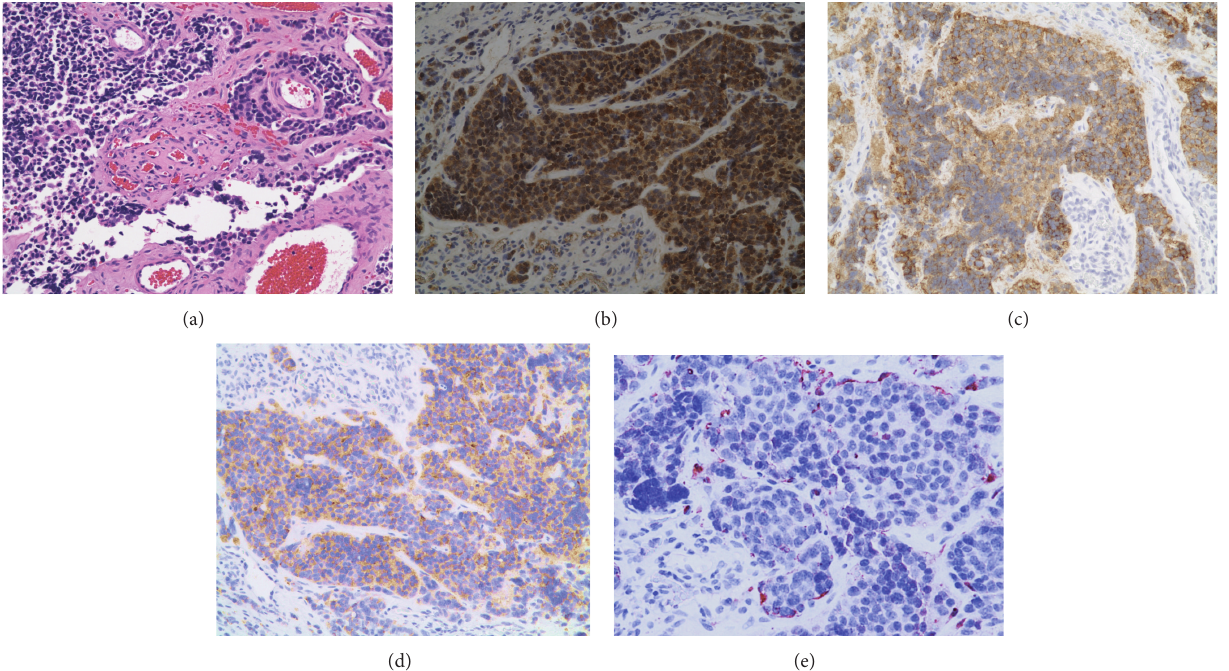
Figure2:HistologicsectionsofT8lesionconfirmthepreoperativeimpressionofametastaticesthesioneuroblastoma(a).Thetumoriscellular and is positive for markers of neuronal (neuron specific enolase (b), synaptophysin (c), and chromograninn (d)), as well as of a sustentacular differentiation (e). Original magnification: ×